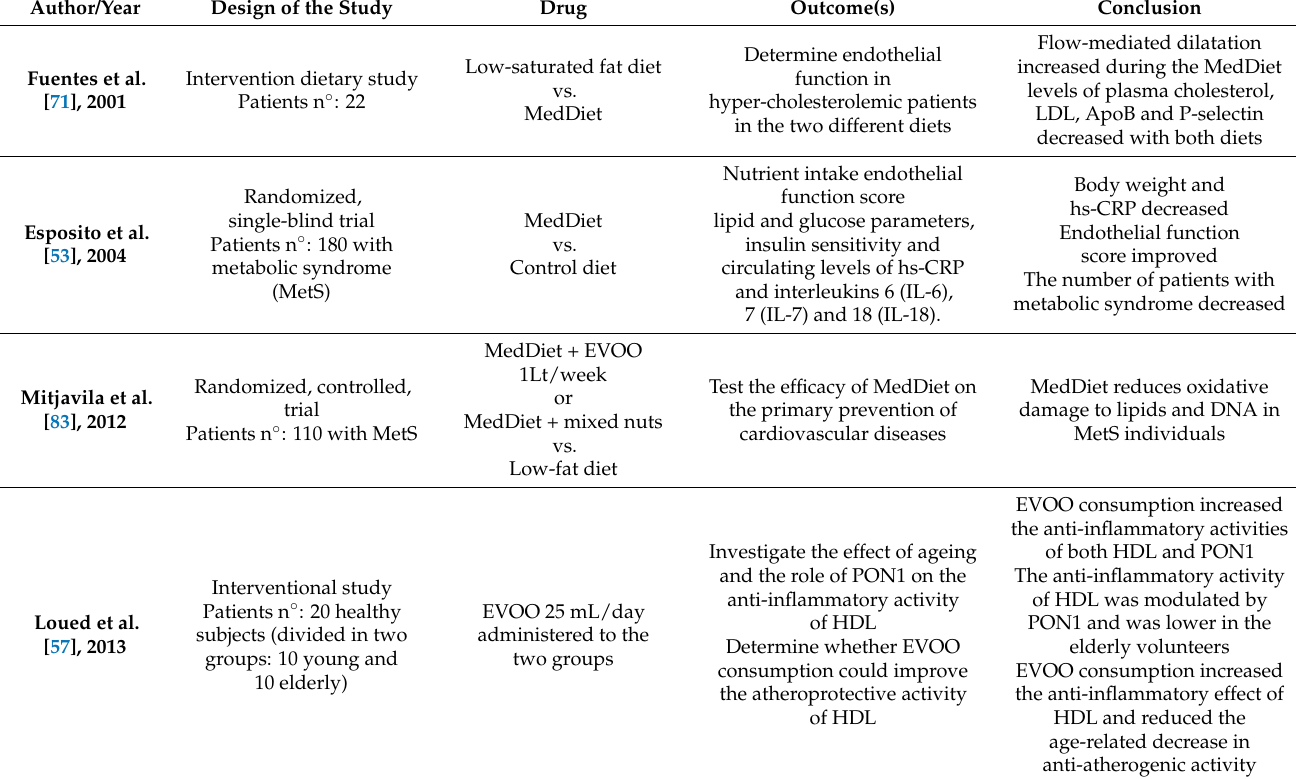
Table 1. Features of the studies published on EVOO and MedDiet beneficial effects.